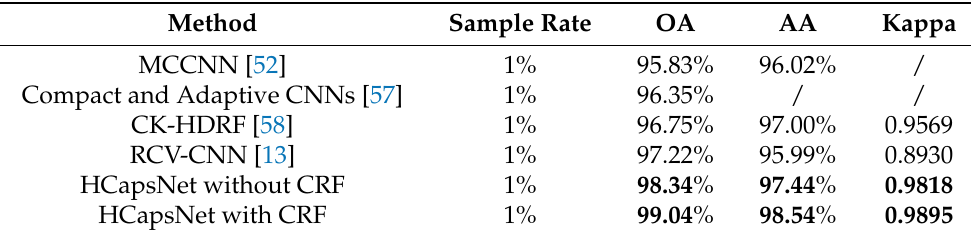
Table 10. Classification accuracy comparison of state-of-the-art methods on the AIRSAR Flevoland